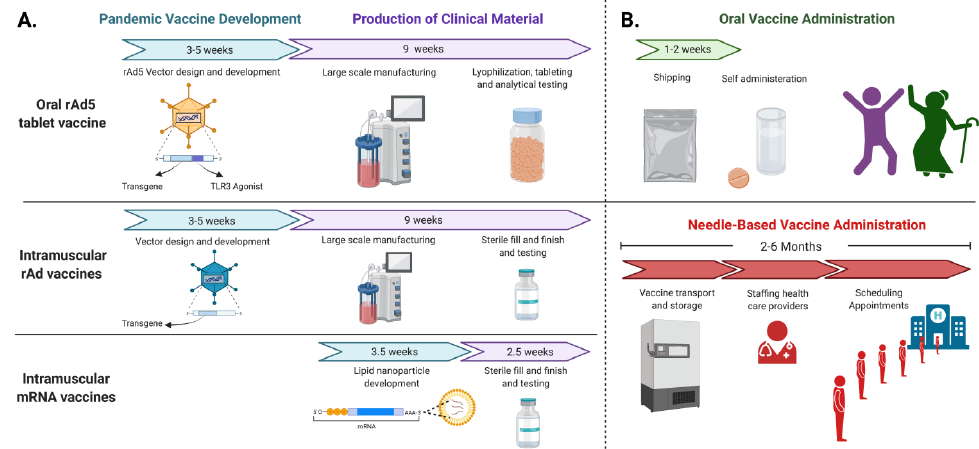
Figure 1. Next generation vaccine production, manufacturing, and distribution timelines during a pandemic. ( A ) Non-replicating recombinant adenovirus serotype 5 (rAd5) vaccine constructs can be